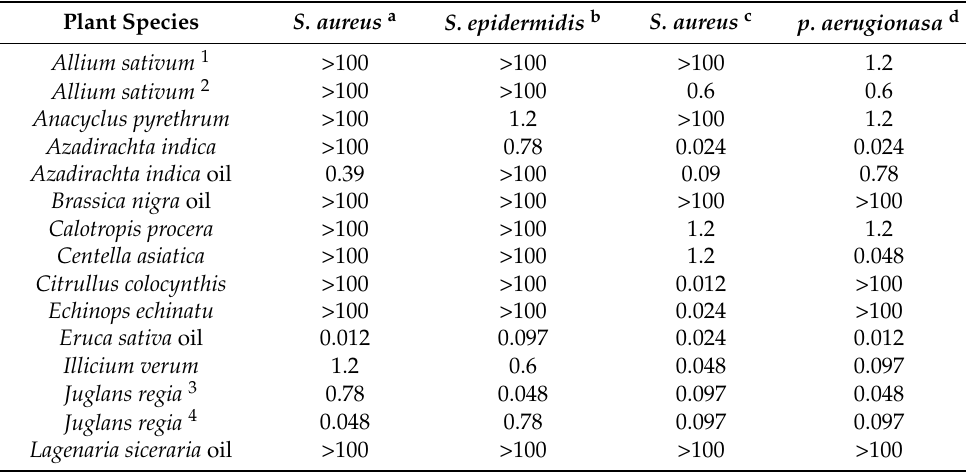
Table 3. Determination of MIC values (mg/mL) of tested plant